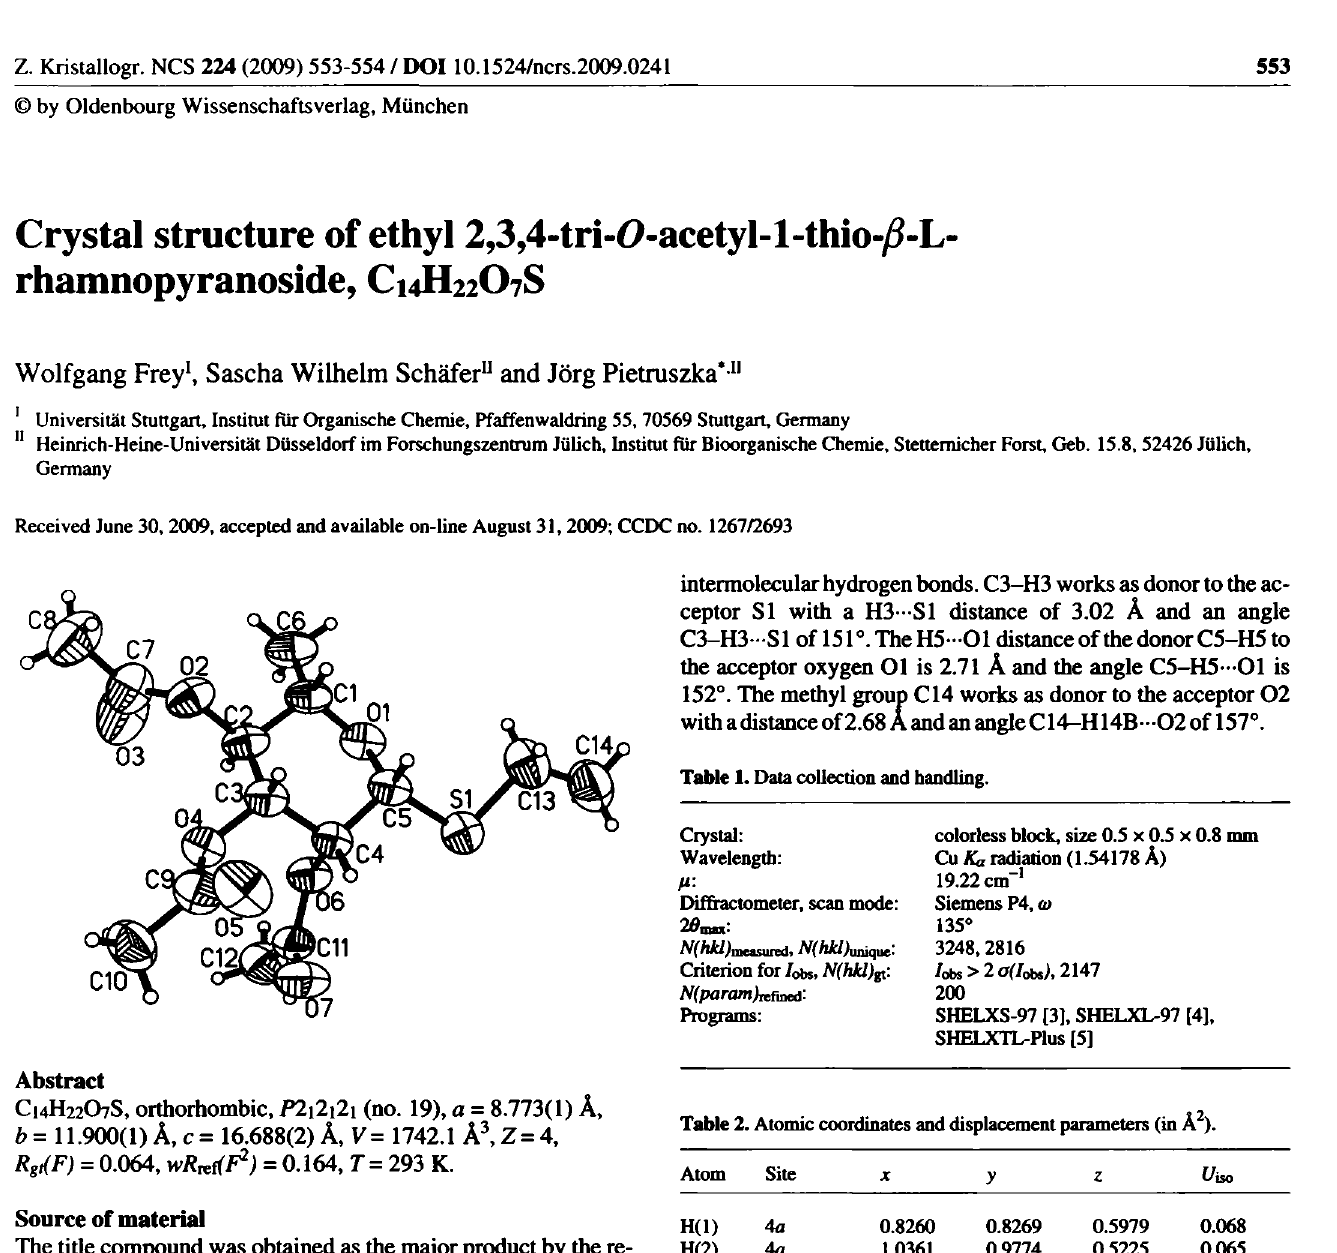
Table 2. Atomic coordinates and displacement parameters (in Â 2